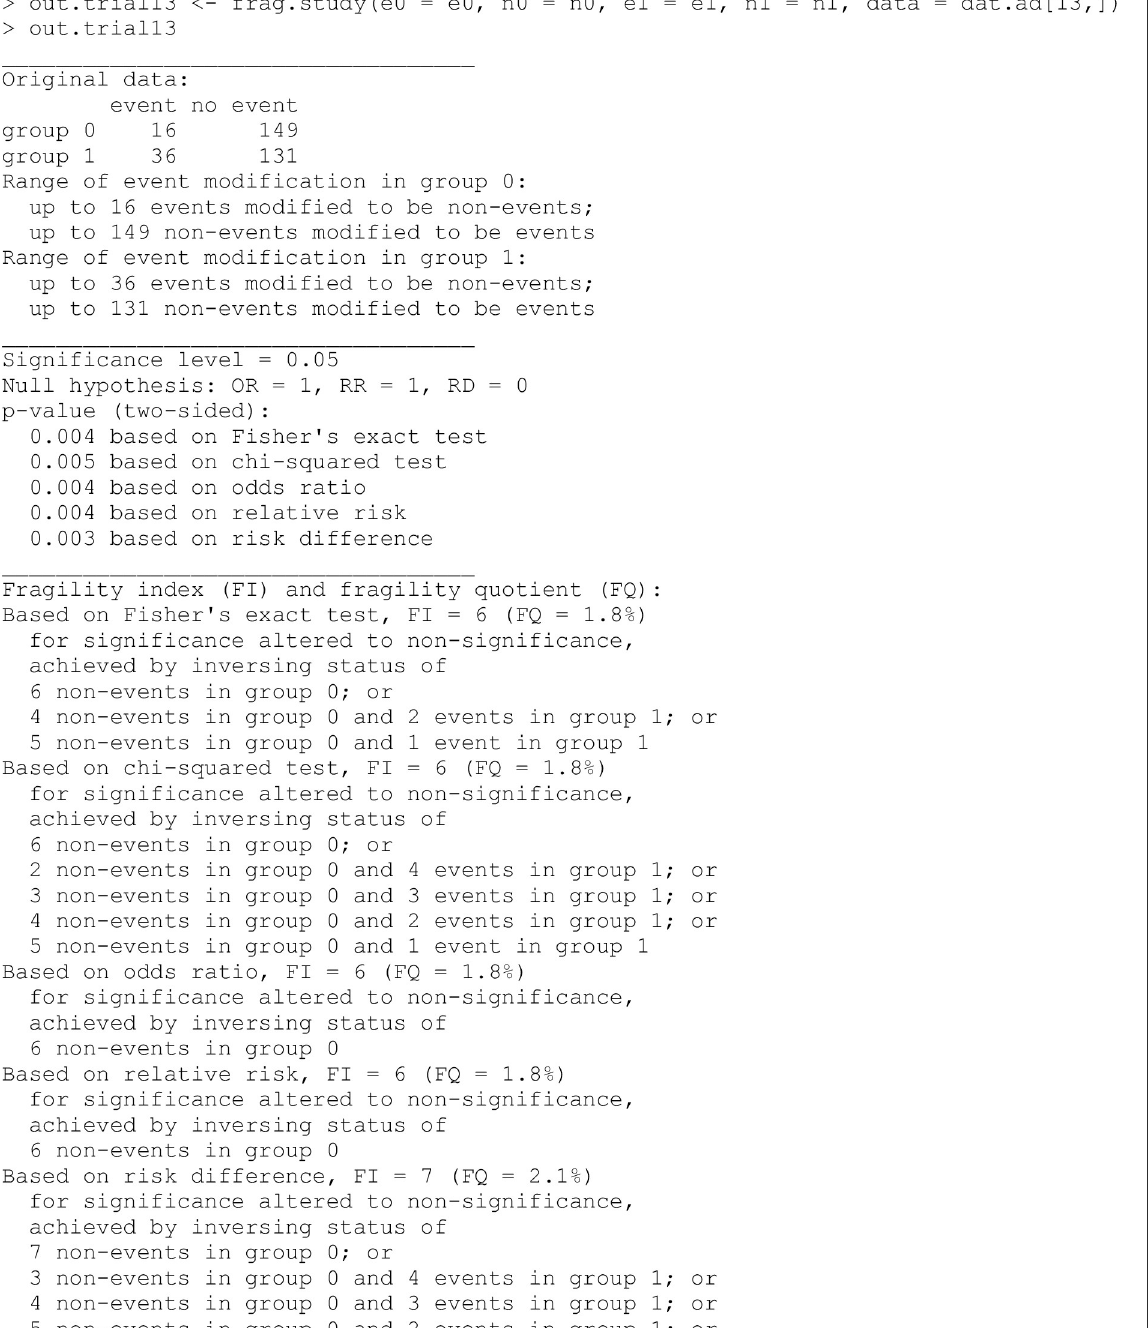
PLOS ONE | https://doi.org/10.1371/journal.pone.0268754 June 1,